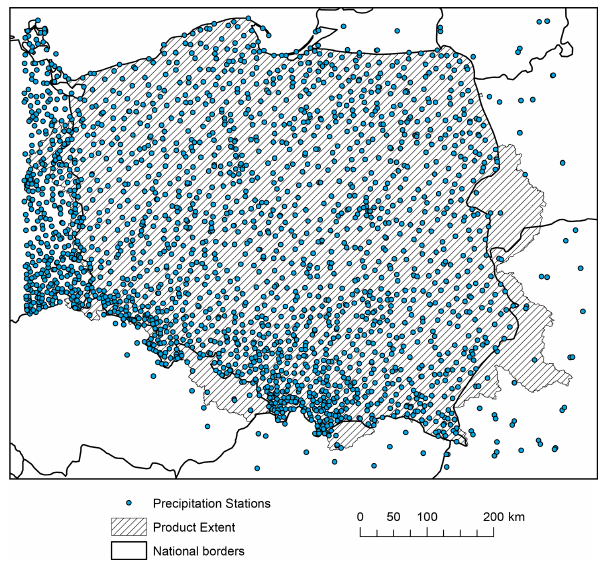
Figure 6. Spatial distribution of precipitation stations used for in- terpolation of the G2DC-PL +